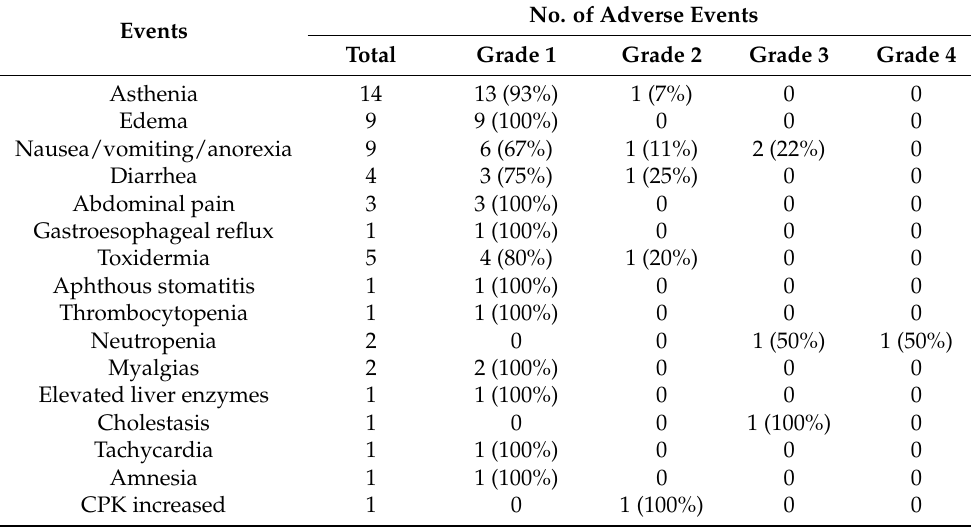
Figure 2. Treatment of DFSPs with IM leads to a decrease of atypical spindle cells density, induction of hyalinic fibrosis (HES coloration), and enrichment of activated T cells (CD3 and CD8 labelling) original magnification × 10. ( A )—Naïve DFSP tumor with atypical spindle cells (HES coloration). ( B , C )—Representative CD3 and CD8 staining on DFSP tumor before TKI treatment. ( D )—DFSP tumor after TKI therapy showing reduction of spindle cells and fibrosis (HES coloration). ( E , F )—Representative CD3 and CD8 staining on DFSP tumor after TKI treatment, showing a moderate tumoral infiltrate of activated T cells. Table 3. Toxicities with TKI